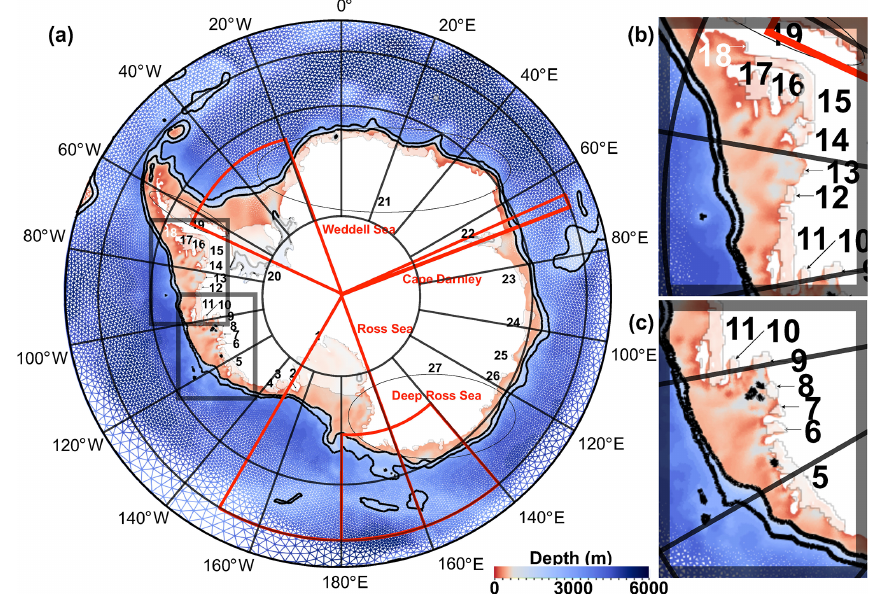
Figure 1. (a) Horizontal grid (triangles) and model bathymetry (color) south of 55 ◦ S in the global model. The bathymetry contours of 1000 and 2500m are shown with black lines. Locations of ice shelves are indicated by numbers summarized in Table 3. Basal melt rates are integrated for several ice shelves in the WS and East Antarctica, bordered by ellipses, for model–data comparison (Table 3). The regions enclosed by red lines represent the RS, deep RS, CD, and WS, in which spatially averaged water mass characteristics are calculated (Table 4 and Fig. 8). Close-ups for the Bellingshausen and Amundsen seas enclosed by the black boxes in (a) are shown in (b) and (c) ,